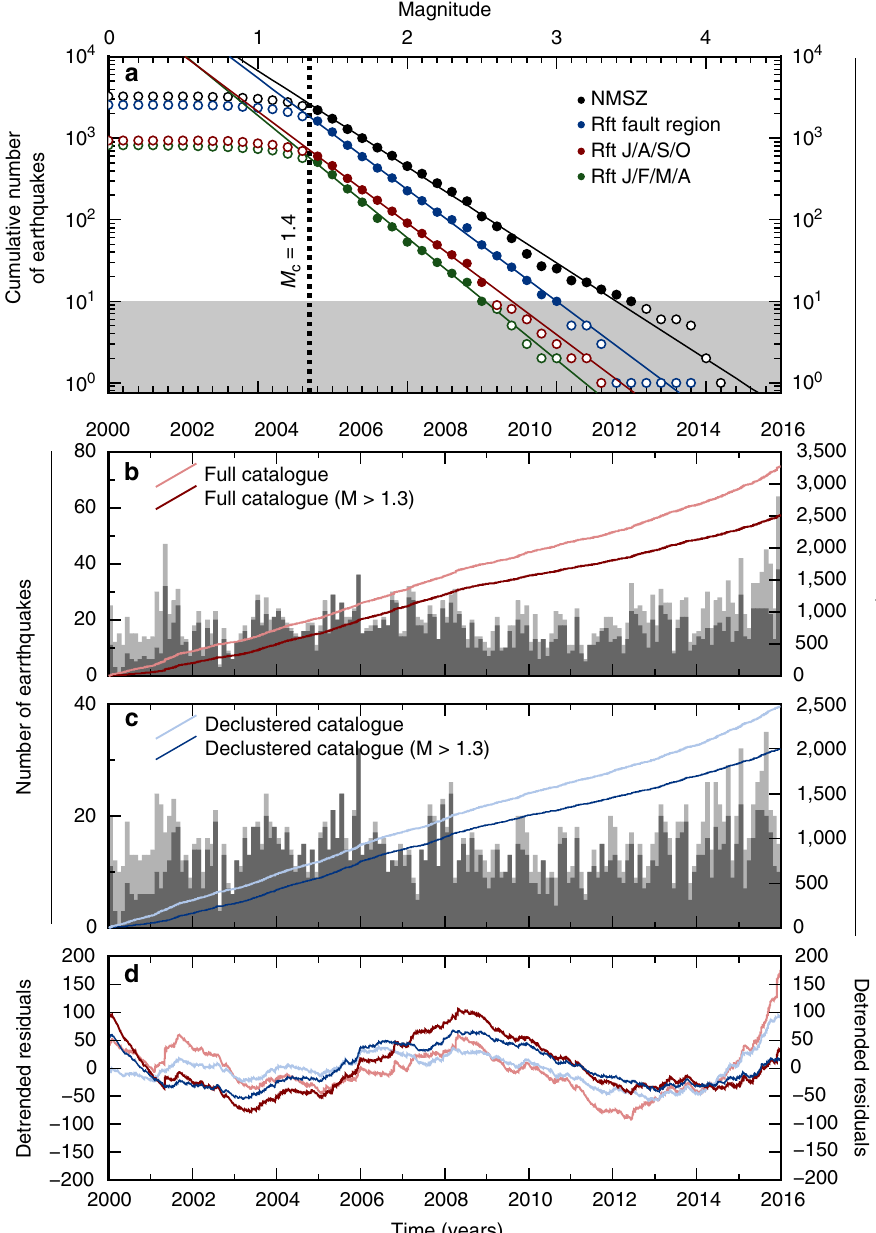
Fig. 2 Seismicity in the New Madrid Seismic Zone (NMSZ). a Gutenberg – Richter plots for the seismic catalogue since 2000 shown in Fig. 1a, for the whole NMSZ (black points), for the Reelfoot fault region only (blue points), and for the Reelfoot fault region only in the months of January, February, March and April (green points) and in the months of July, August, September and October (red points). Filled circles are those used in calculating best- fi t Gutenberg – Richter parameters, shown by the coloured lines. Un fi lled circles are those excluded due to being either below the calculated magnitude of completeness, or when there are fewer than 10 recorded earthquakes. b , Histogram of earthquake frequency, binned at 0.1-year intervals for the full NMSZ catalogue (light grey), and considering only those earthquakes above the magnitude of completeness (dark grey). Lines indicate the cumulative number or earthquakes since 1 January 2000. c As in b , but for the NMSZ earthquake catalogue after declustering. d Cumulative number of earthquakes since 1 January 2000 with a best- fi t linear trend removed. Colours are as in b and